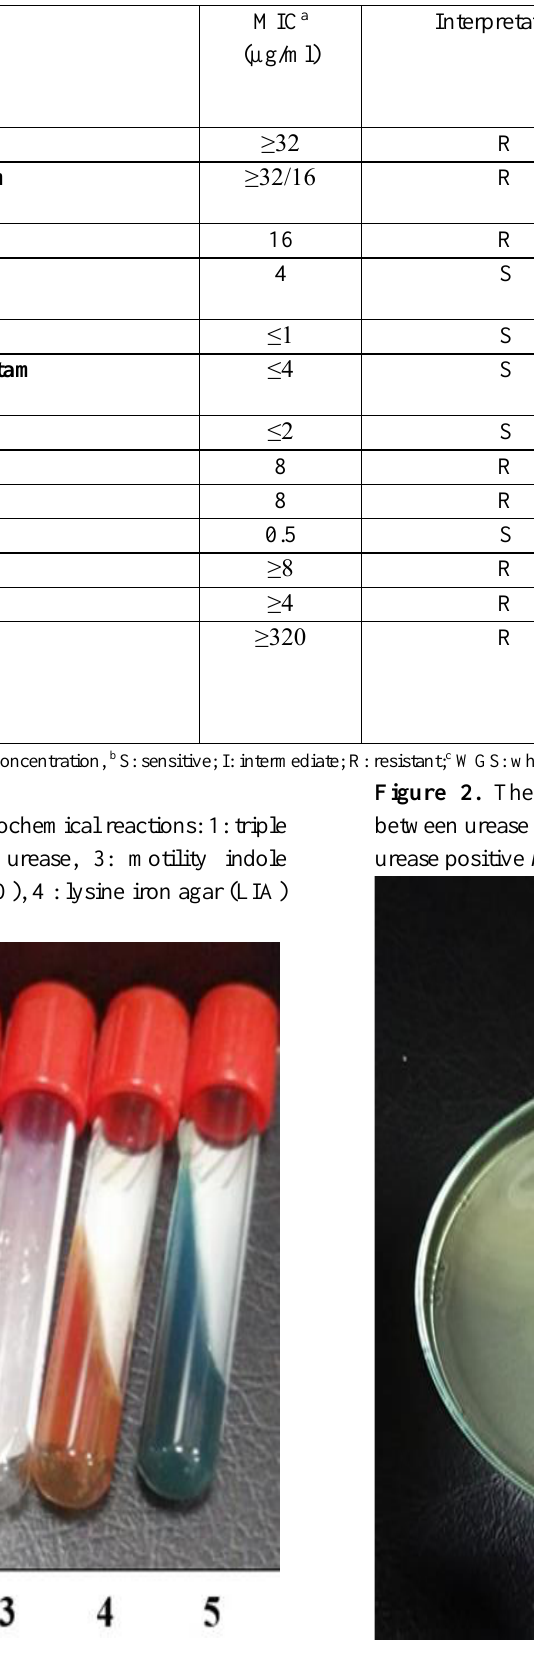
Table 1. Antibiotic sensitivity results of urease negative P. mirabilis strain according to CLSI, 2020.